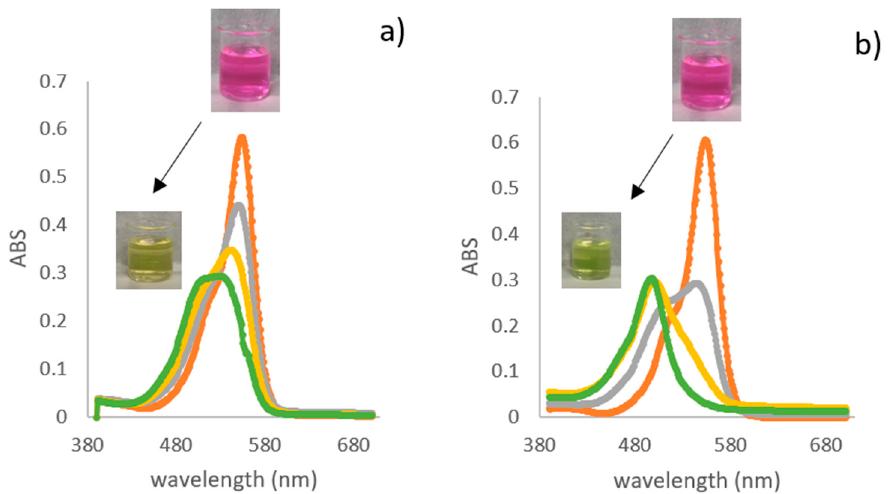
Figure 3. Absorbance of RhB solutions after irradiation under visible light at 0 min (orange), 40 min (gray), 80 min (yellow), and 100 min (green). Time 0: λ max 554 nm; time 100: λ max 527 nm for TACR ( a ) and 498 nm for TiO 2 :SiO 2 ( b ).